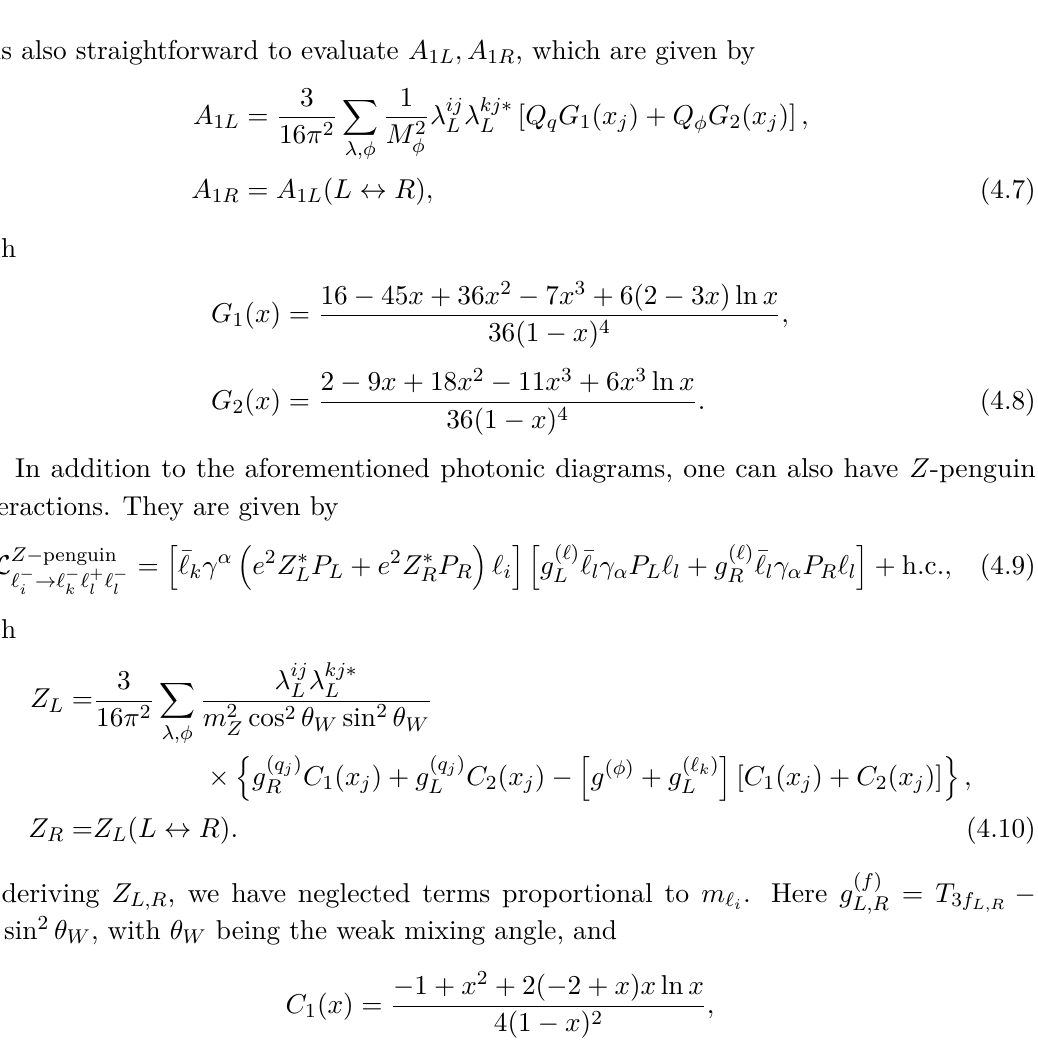
Table 2 . Current experimental bounds on the BR ( ‘ i → ‘ k γ ) . Future sensitivities are presented on the last